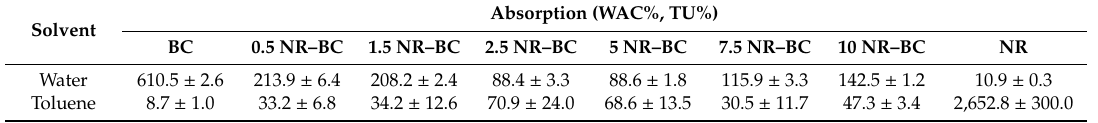
Table 2. Water absorption capacity (WAC%) and toluene uptake (TU%) of NR–BC50 films.